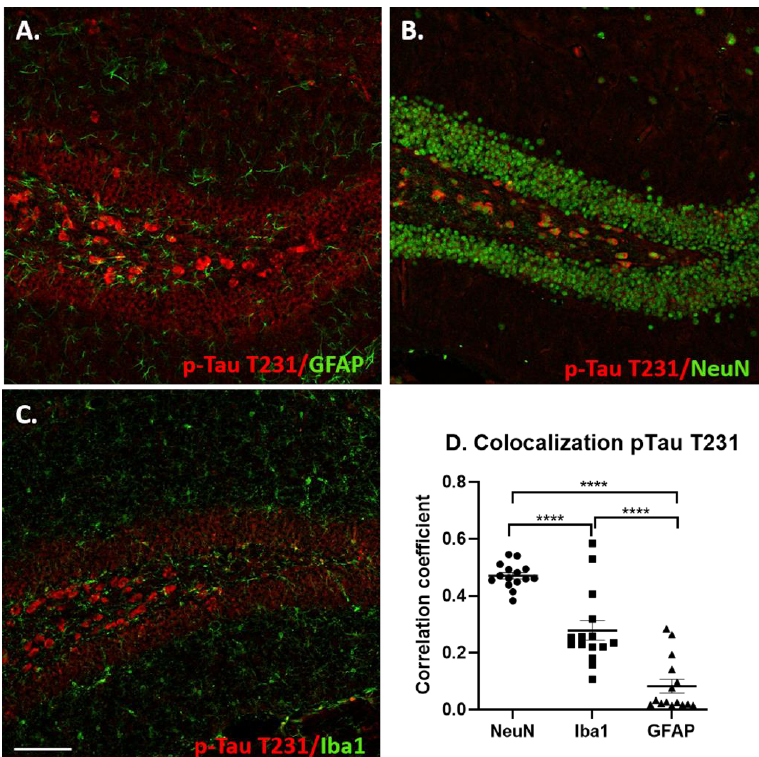
Figure 10. Co-localization of p-Tau T231 staining with neuronal and glial markers. ( A ) Double labeling for p-Tau T231 (red) and GFAP (green), ( B ) double labeling for p-Tau T231 (red) and NeuN (green), ( C ) double labeling for p-Tau T231 (red) and Iba1 (green). Evaluation of the double-labeled sections revealed p-Tau T231 staining was largely located to neurons, with some staining observed in microglia (Iba1) and to a lesser extent astrocytes (GFAP). The scatter plot graph ( D ) shows the correlation coefficients for p-Tau T231 colocalization with NeuN, Iba1 and GFAP (****, p < 0.0001).